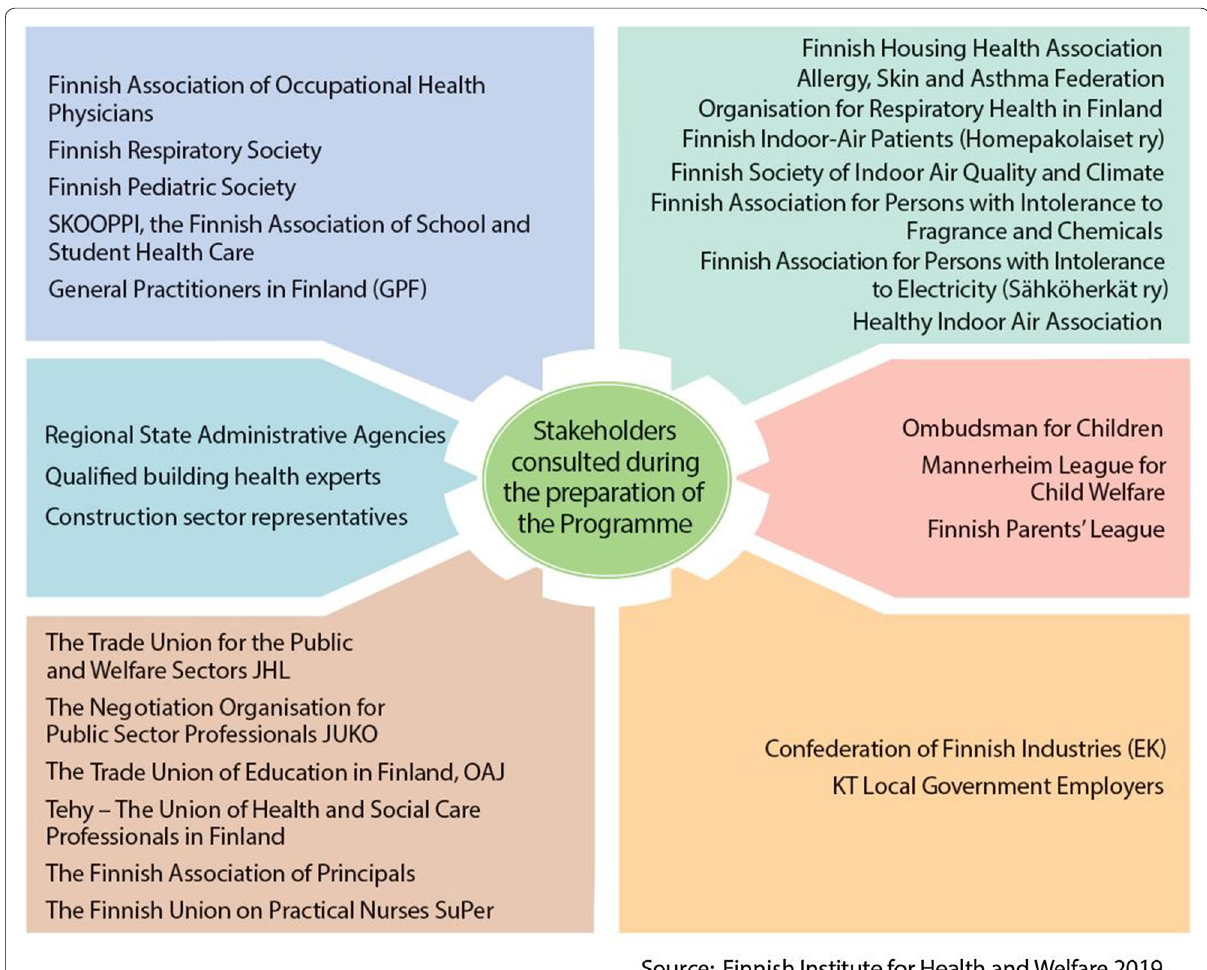
Fig. 2 Stakeholders consulted during the preparation of the